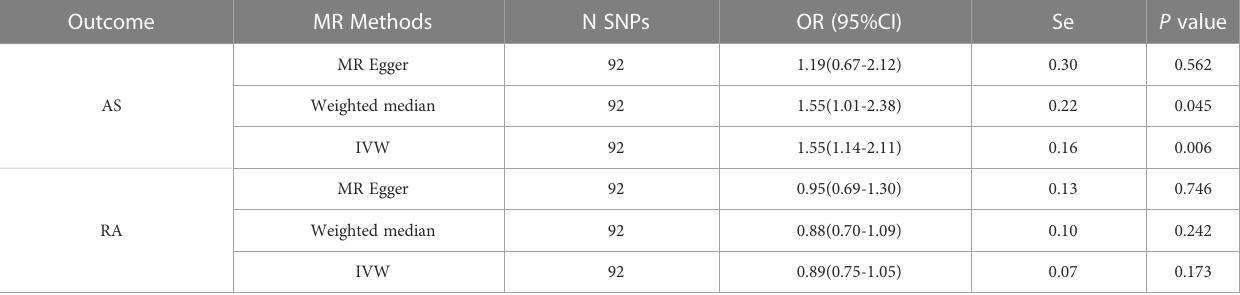
TABLE 1 MR Results of LTL Use on Risk of Ankylosing Spondylitis and Rheumatoid Arthritis. Outcome MR